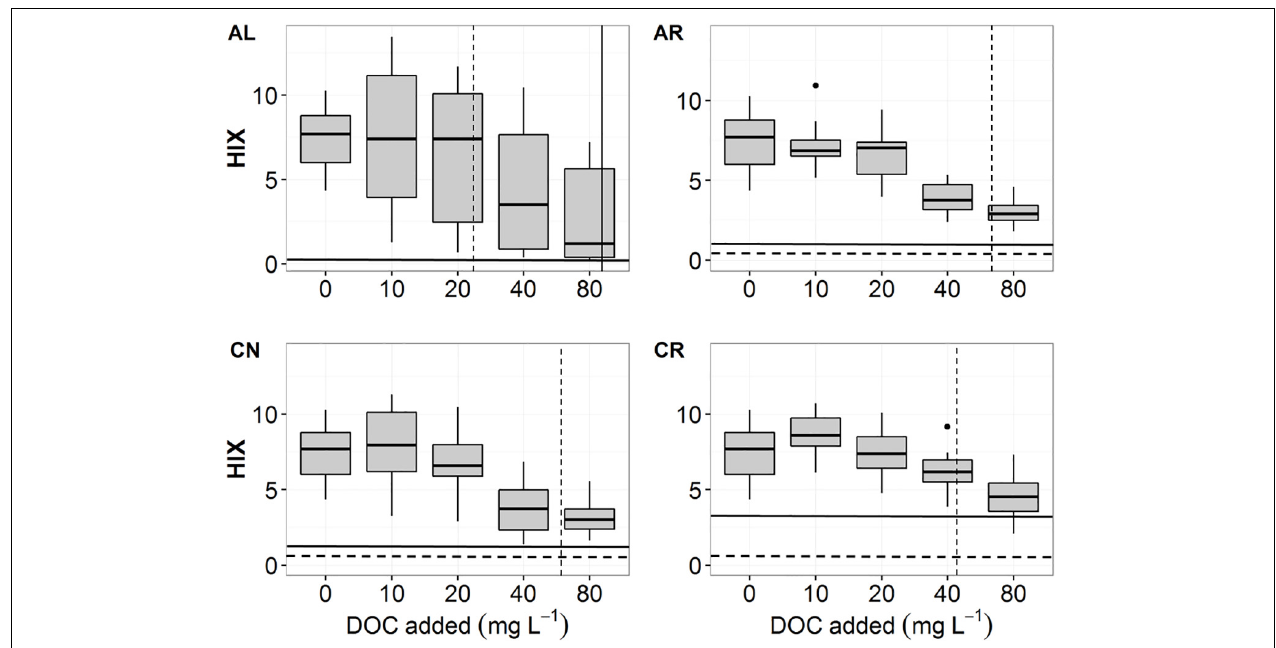
FIGURE 4 | HIX values of post-sorption solutions for all four leachates – AL, AR, CN, CR. The dashed horizontal lines indicate HIX values of fresh, pre-sorption leachates (AL = 0.06, AR = 0.37, CN = 0.73, CR = 0.58). The solid horizontal lines indicate HIX values for pure leachates after 24 h of shaking (AL = 0.06, AR = 1.17, CN = 1.34, CR = 2.99). The dashed vertical lines indicate the average NPC for aspen soils (AL = 24.6, AR = 70.4, CN = 65.2, CR = 44.2 mg L − 1 ). Average NPC for conifer soils is indicated with a solid vertical line for AL (AL = 90.5 mg L − 1 ), but could not be visualized for the other leachates due to being out of range (AR = 181.5, CN = 101.7, CR = 186.4 mg L − 1